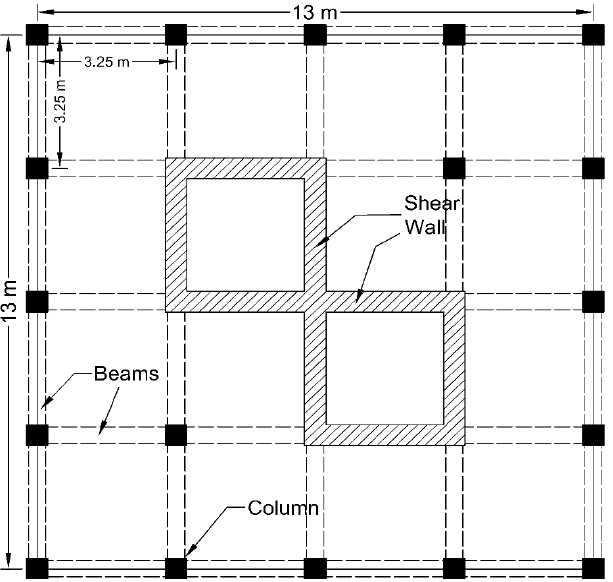
Figure 1. Detailed plan of the reference floor of the multi – story building in this study.